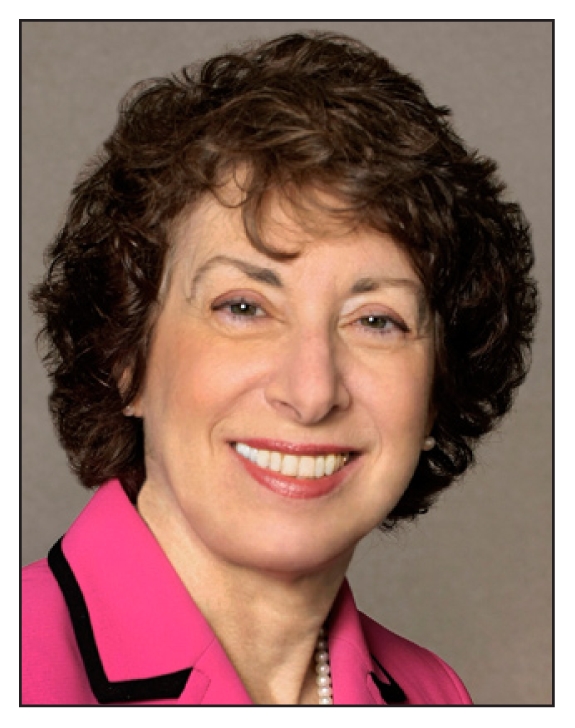
Linda S. Birnbaum